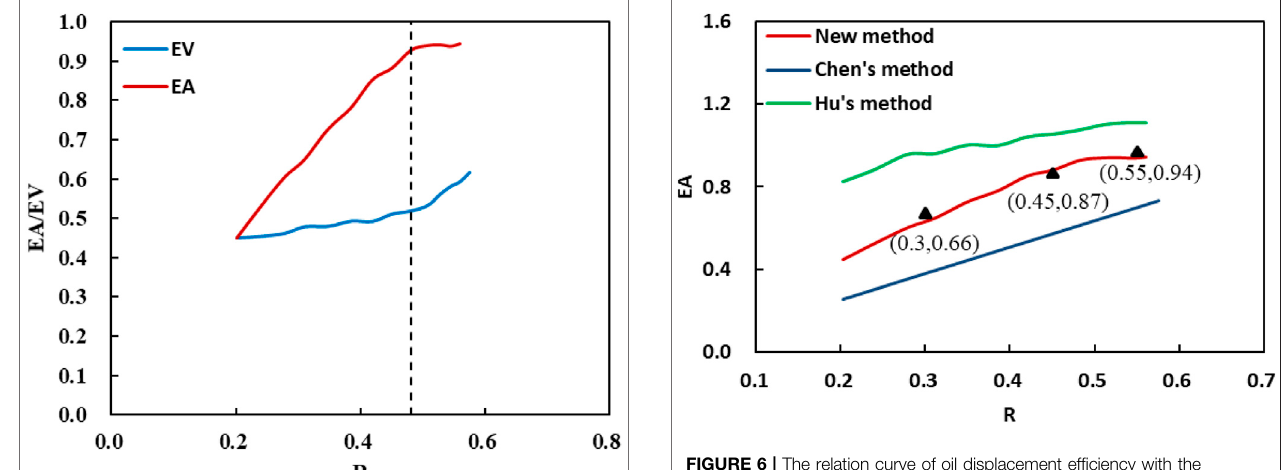
FIGURE 6 | The relation curve of oil displacement ef fi ciency with the recovery of reservoir.